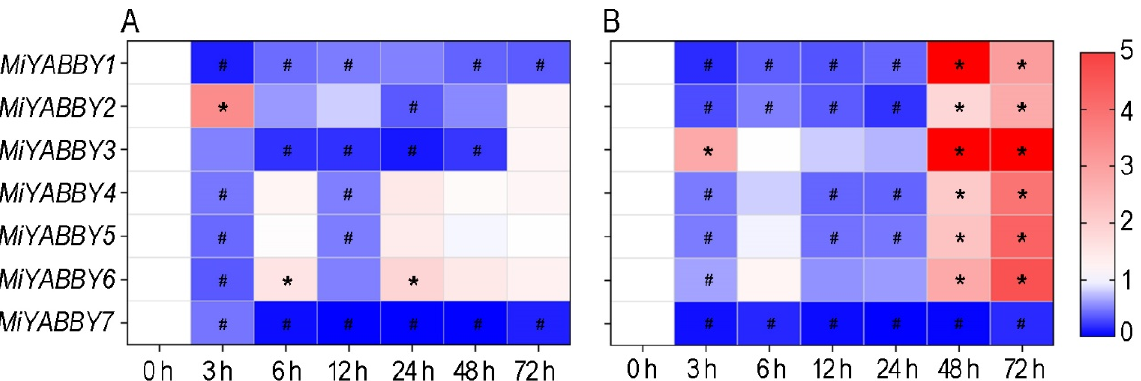
Figure 6. Relative expression analysis of the MiYABBY gene family under phytohormone treatments in mango. ( A ) shows the results of the MeJA treatment, and ( B ) shows the results of the SA treatment. The calculation method was 2 − ∆∆ CT , and ‘*’ means the value exceeds 1.5, while ‘#’ means the value is below 0.5.